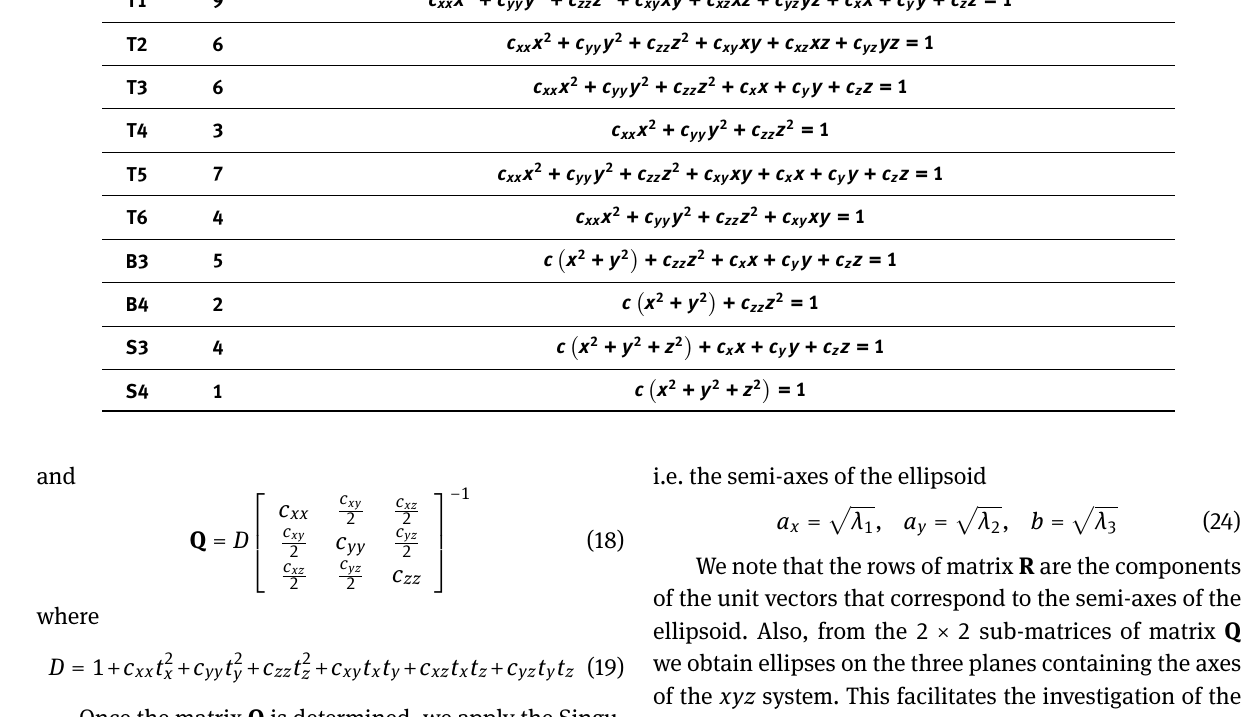
Table 3. Mathematical models for different cases of a triaxial ellipsoid and degenerate cases Case m 0 Mathematical model